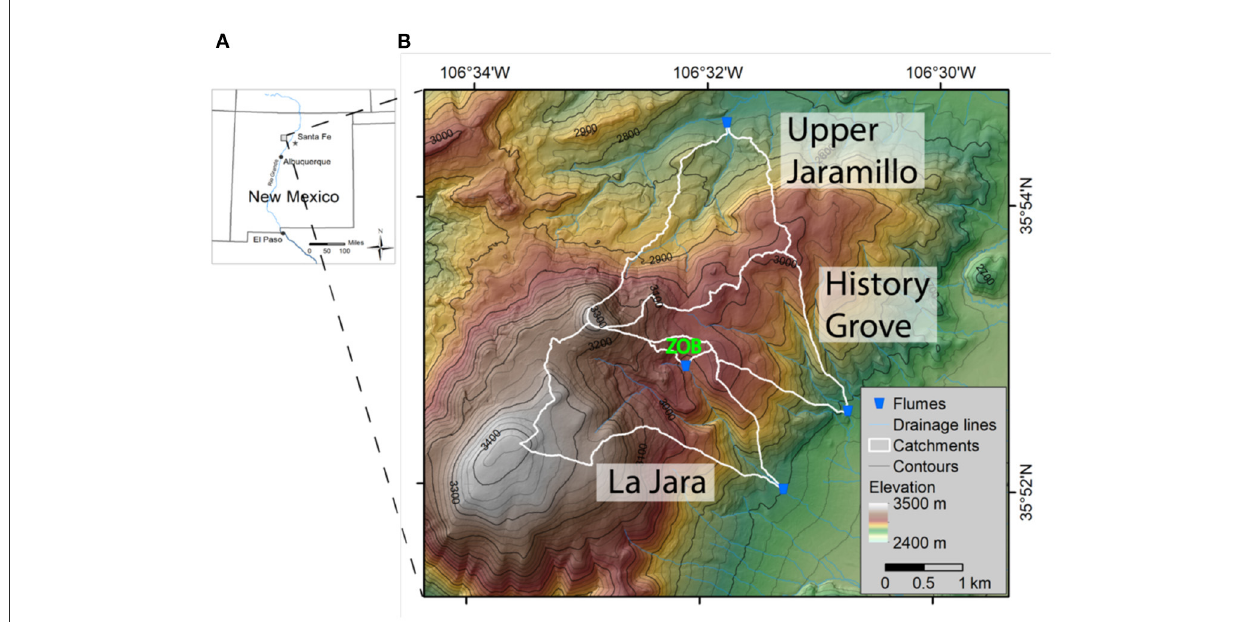
FIGURE1 (A) The Jemez River Basin Critical Zone Observatory (JRB-CZO) located on the Valles Caldera National Preserve (VCNP) in northern New Mexico. (B) Headwaters first-order study catchments: La Jara, History Grove and Upper Jaramillo originate on different aspects around highest peak (Redondo Peak) at the VCNP. The zero-order-basin (ZOB) is nested within La Jara